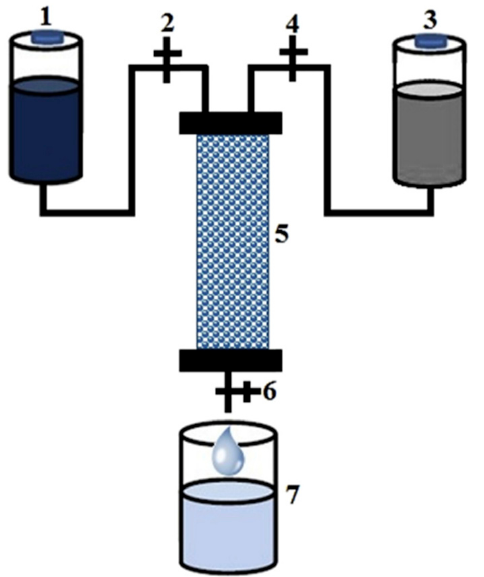
Figure 8. Example of a packed bed bioreactor used for dye degradation; (1) dye vessel, (2,4 and 6) flow control valves, (3) substrate vessel, (5) immobilized HRP enzyme, and (6) decolorized product Reprinted from [79] with permission from Elsevier. Copyright © 2021 Elsevier B.V. License Number: 5174590020620.